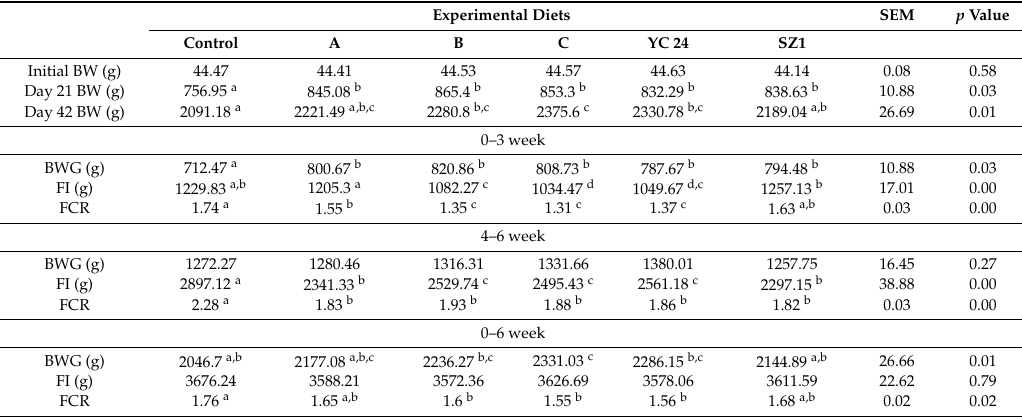
Table 7. The e ff ect of di ff erent treatment of yeast culture on the growth performance of broilers. BW = body weight; BWG = body weight gain (g / w); FI = feed intake (g / w); FCR = feed conversion ratio (g / g). a–c means within the same rows without the same superscript letter are significantly di ff erent ( p <